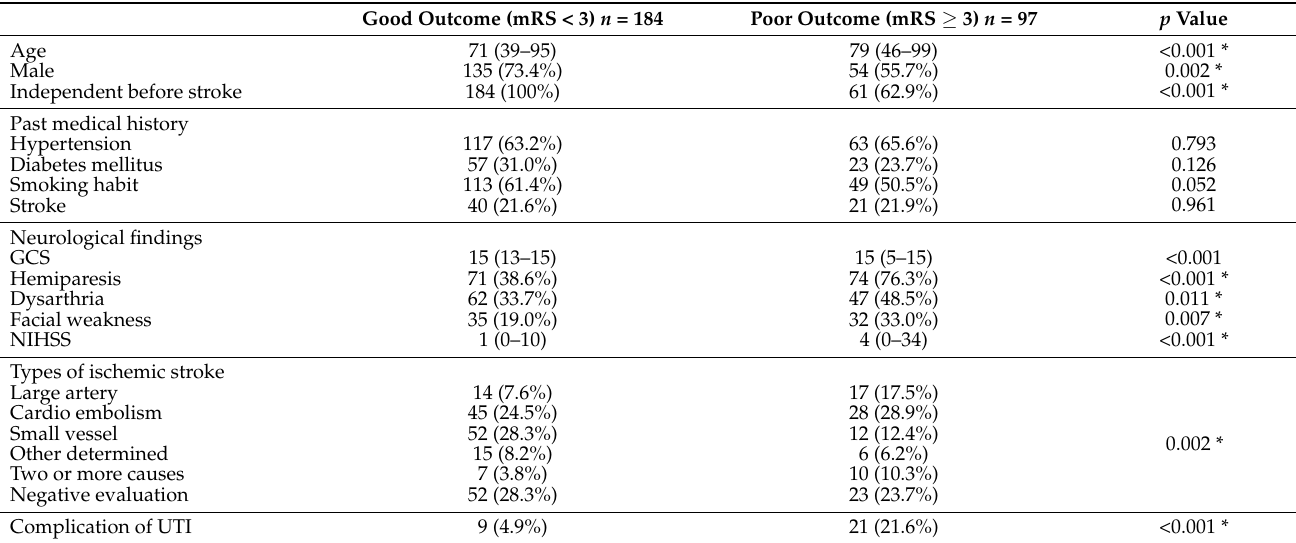
Table 2. Comparison between patients with good and poor